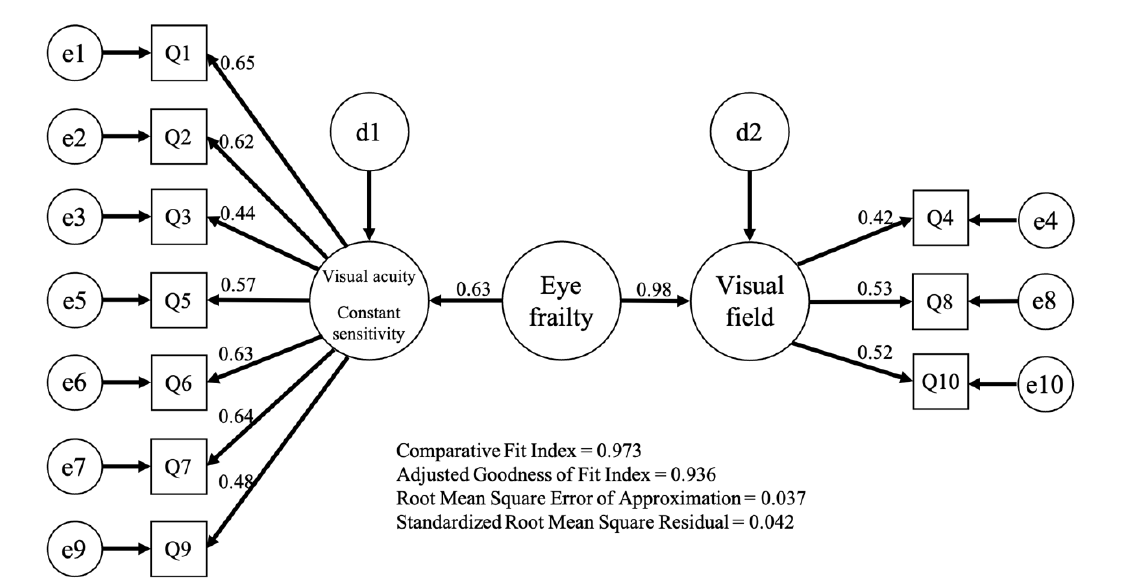
Figure 1. Confirmatory factor analysis in eye frailty self-check.